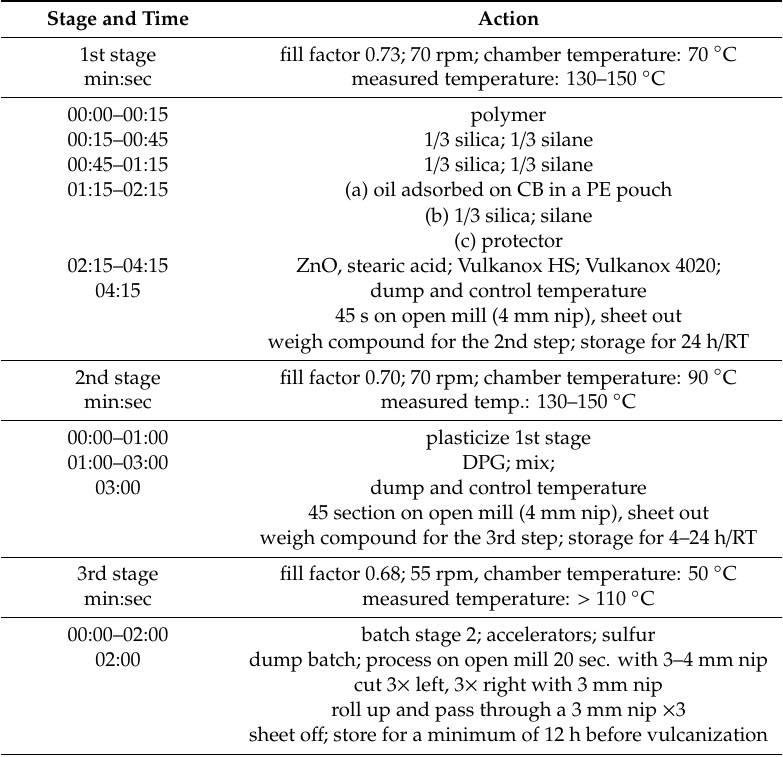
Table 3. Mixing process for the green tire compounds filled with 80 phr of